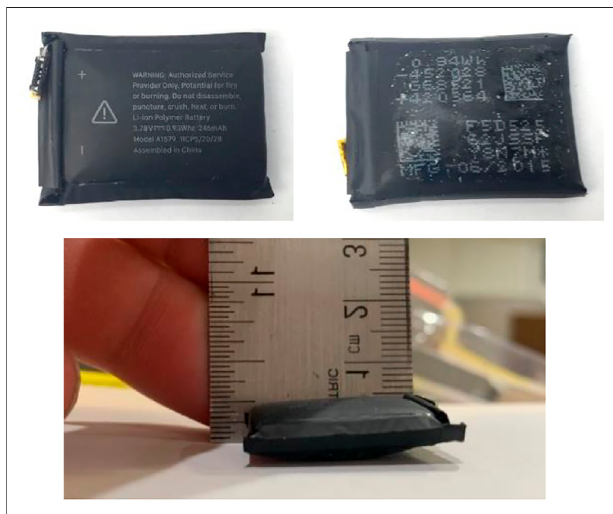
FIGURE 3 | A swollen Apple Watch battery (Apple,